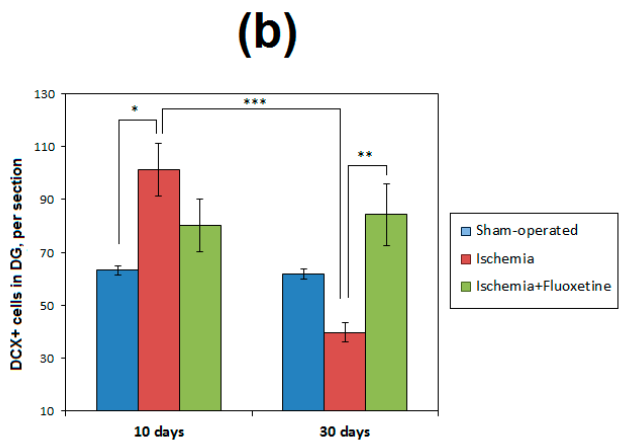
Figure 4. Fluoxetine effect on neurogenesis in the DG. ( a ) Micrographs of the DG of the hippocampus in the sham-operated animals, positive controls, and fluoxetine-treated animals at day 31 after GCI. Brain sections were stained with DCX and DAPI, 20× magnification; ( b ) Comparison of the number of DCX+ cells in the SGZ between the groups and time points. Significant differences between the groups according to ANOVA after Bonferroni’s correction for multiple comparisons: *** p < 0.001, ** p < 0.01, * p < 0.05.